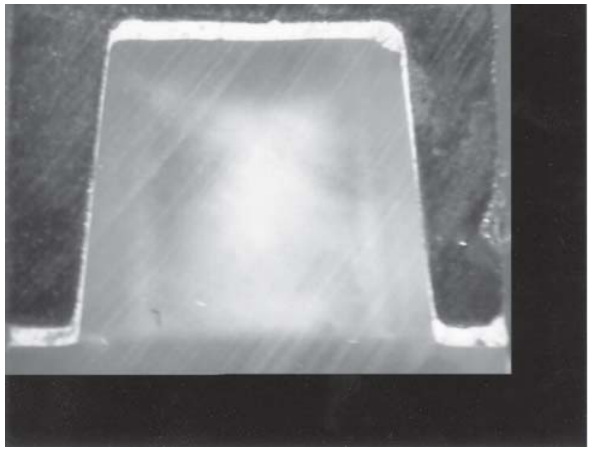
FIGURE 4- 430ºC/100% group